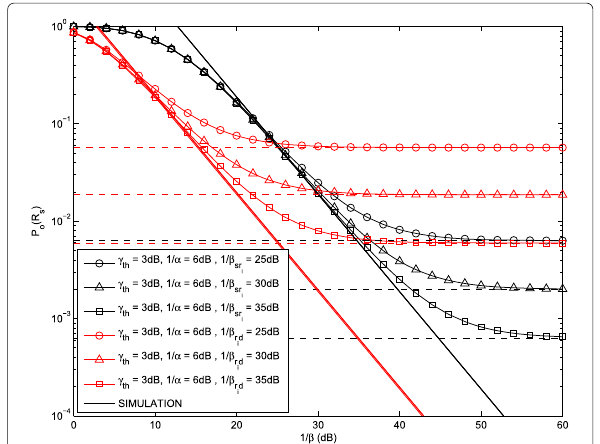
Fig. 5 Outage probability with no direct link between both S − D and Fig. 6 Outage probability of balanced optimal relay selection scheme = 25,30, S − E for 1 /α = 6 dB, γ th = 3 dB, and R s = 1.0 with 1 /β sr when either ICSI or SCSI is known with no direct link between both i = 25,30, and 35 dB of single unbalanced relay and 35 dB and 1 /β r S − D and S − E for N = 2,3, and 4; R s = 1.0; 1 /α = 12,9,6, and 3 dB; i d system and γ th = 3